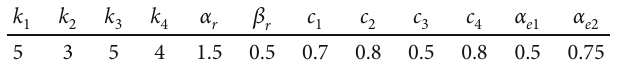
Table 1: Adaptive multiple power reachable SMC guidance law